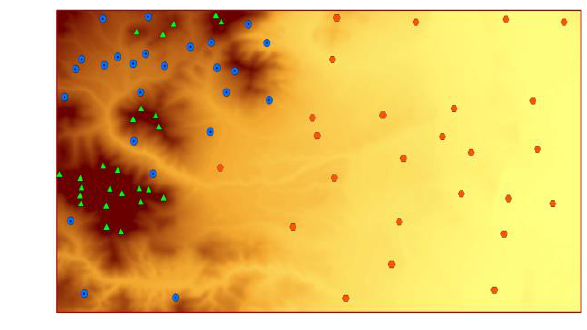
Figure 10.Separation of Points(Green Triangle= M, Blue Point Dot Inside= A, Red Circle Point= P)